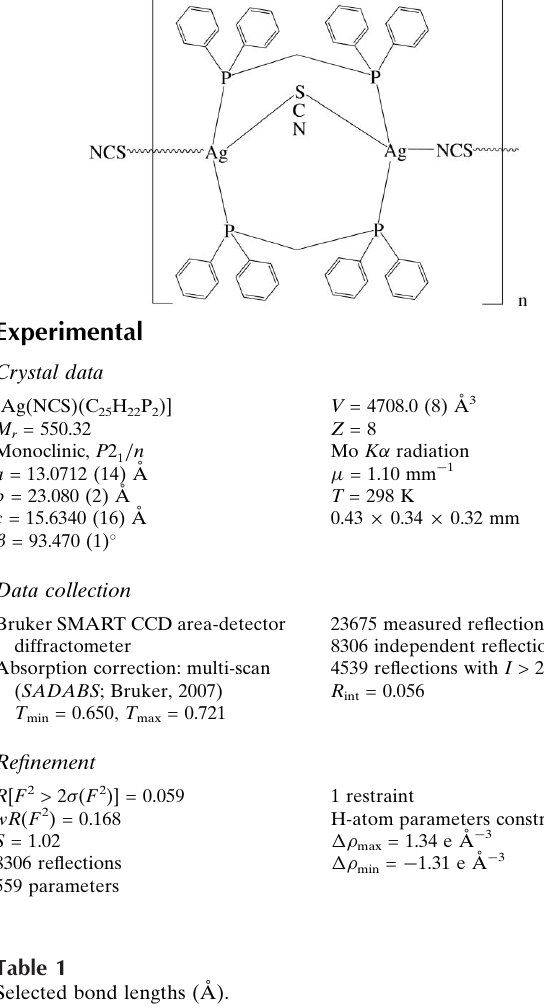
Selected bond lengths (A˚